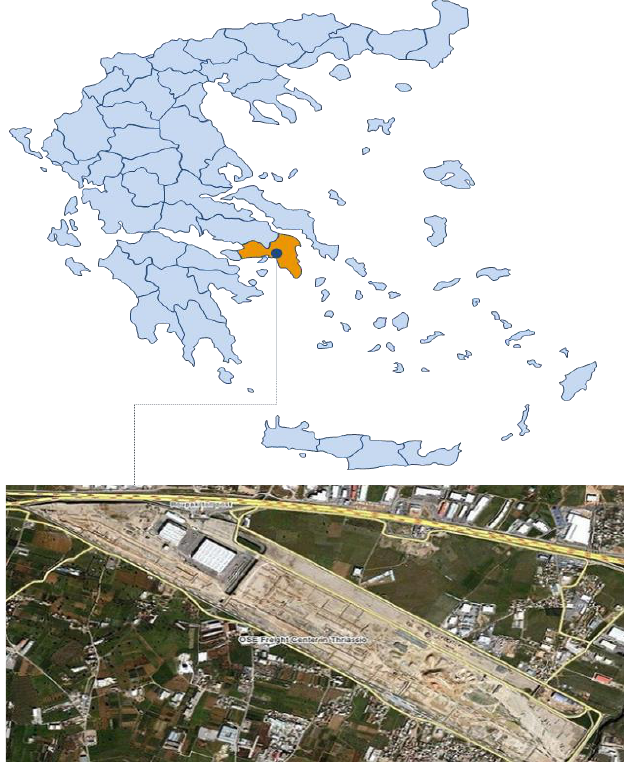
Fig. 1. Location of thriasio logistics centre in